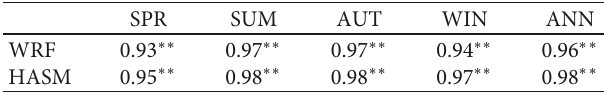
Passing the confidence test of 99%. ∗∗